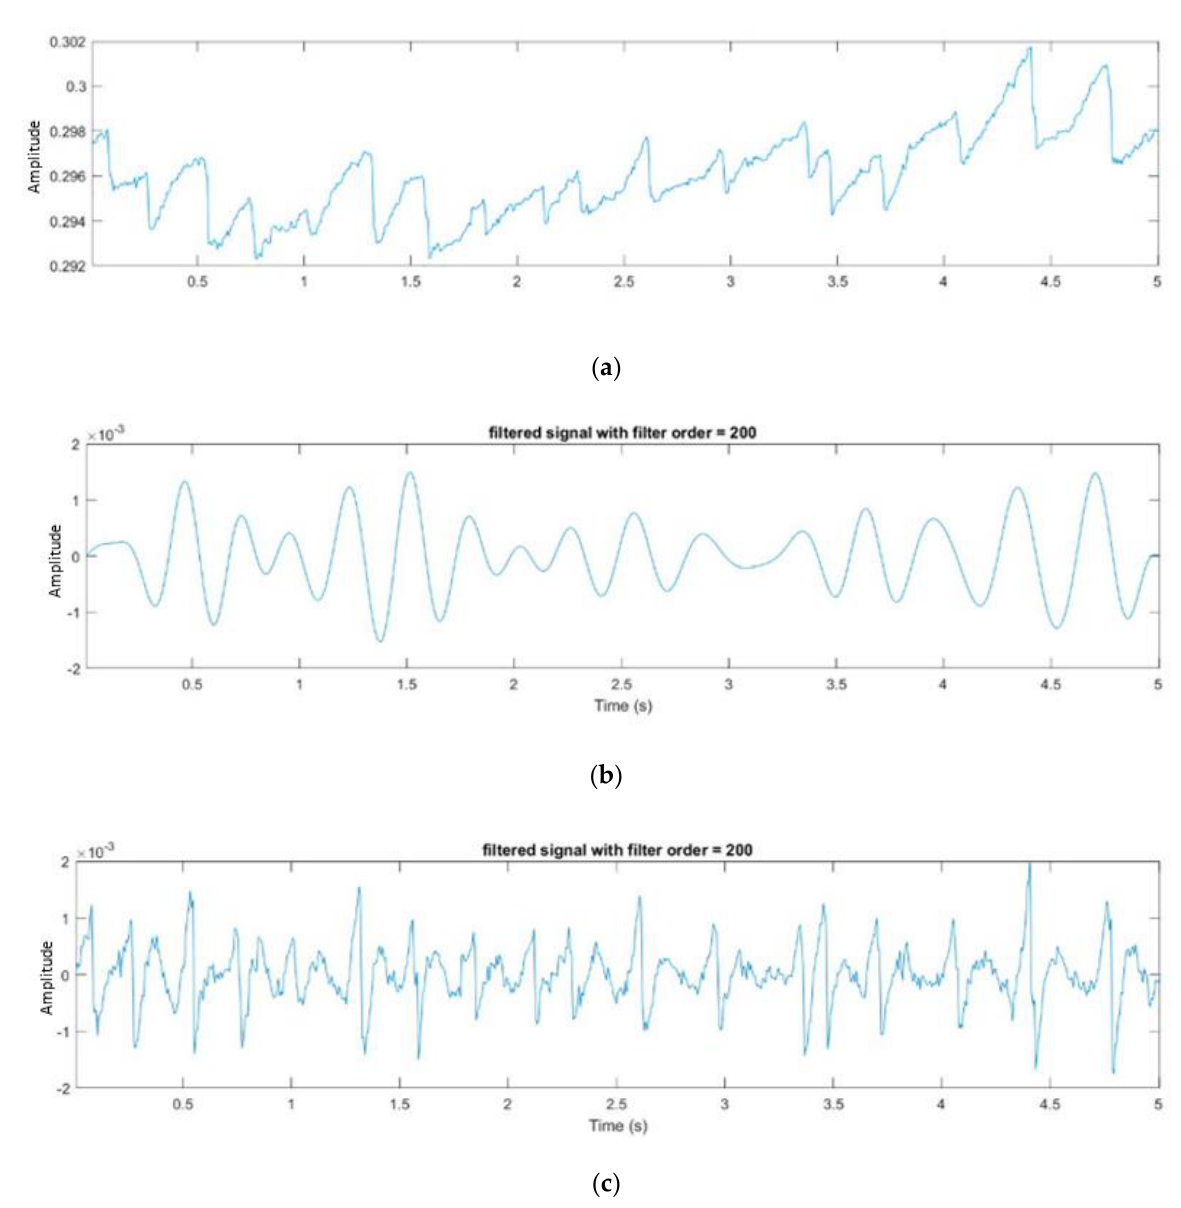
Figure 9. ( a ) Original signal; ( b ) Band-pass filtered signal; ( c ) High-pass filtered signal. Table 1. FP recognition rate of each method in OKN and OKN with